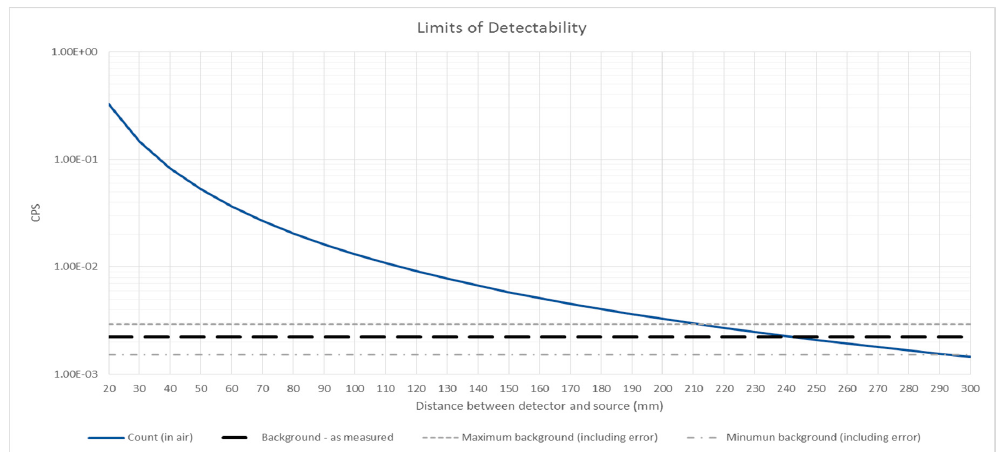
Figure 8. Limits of detectability showing the drop off in signal due to increased distance between sensor and source. The recorded background count ± the calculated error is shown.